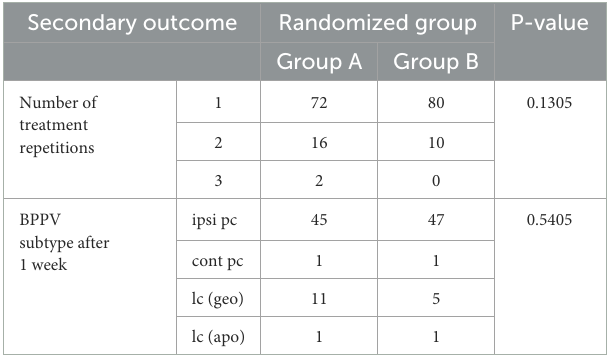
TABLE 2 Secondary